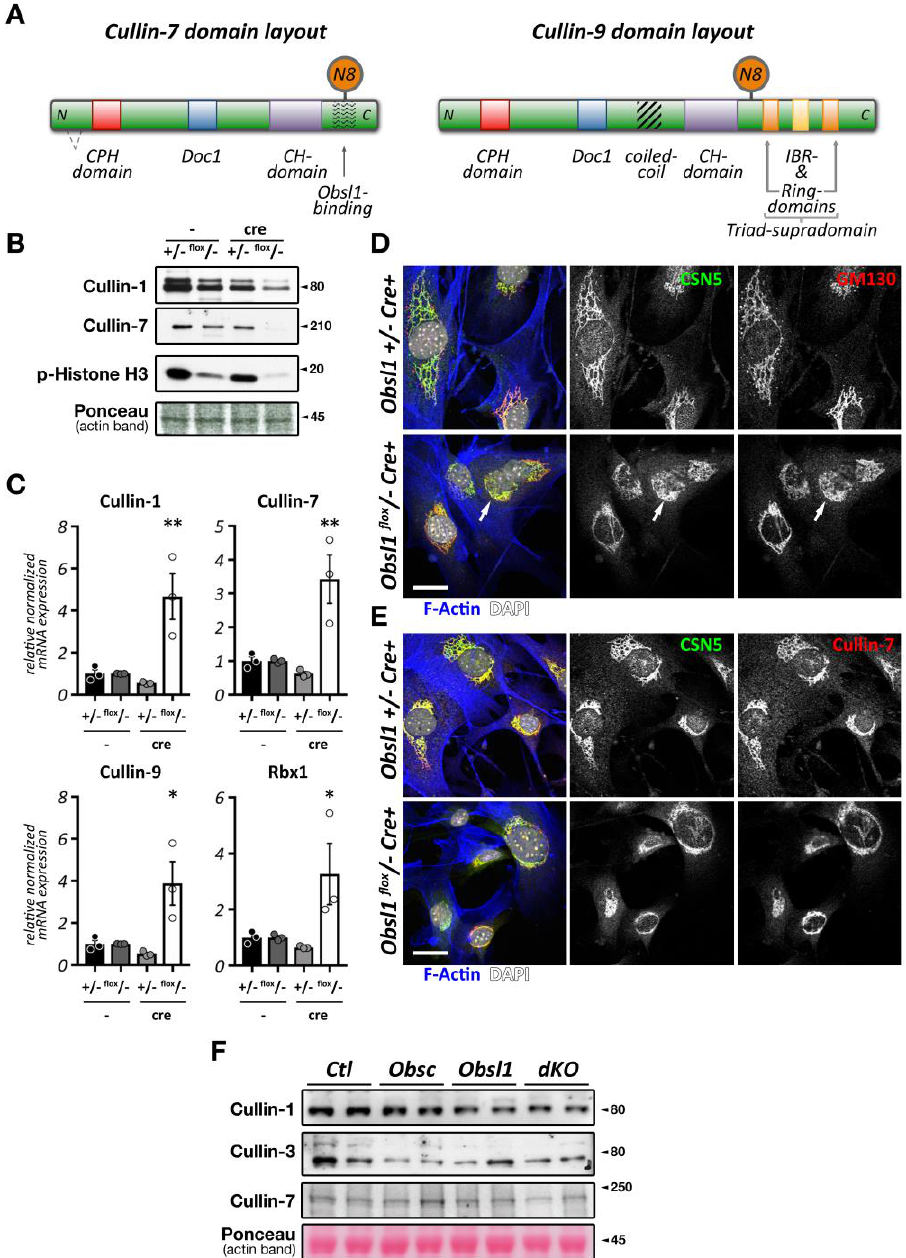
Figure 7. Cullin-7 and cullin-9 E3-ligases, and effects of Obsl1 for cullin E3-ligase expression and localization. ( A ) Cullin-7 and cullin-9 domain layout. Domain organization, mapped neddylation sites (N8), and Obsl1 interaction sites, as well as splicing in cullin-7, are shown. ( B ) Ablation of Obsl1 in mouse lung endothelial cells results in a reduction of cullin-1 and loss of cullin-7 on the protein level. Cells also show reduction in levels of phosphorylated histone H3. Ponceau stained actin bands are shown as loading controls. ( C ) Analysis of cullin-1, cullin-7, cullin-9, and Rbx1 mRNA expression levels in mouse lung endothelial cells with genetic ablation of Obsl1 . Expression was normalized to S18. * p < 0.05, ** p < 0.01 vs. +/- (cre -) controls as determined by ANOVA analysis. ( D , E ) Effect of Obsl1 deletion on the localization of Cop9 subunit Csn5 (green in D,E) and cullin-7 (red in E). Cells were counterstained with GM130 (red in D), as well as fluorescently labeled phalloidin (blue in overlay) and DAPI (white in overlay). Arrow highlights areas of disorganized Golgi structure upon loss of Obsl1. Scale bar = 10µm. ( F ) Analysis of cullin-1, cullin-3, and cullin-7 protein levels in control (Ctl), obscurin knockout (Obsc), Obsl1 knockout (Obsl1), or obscurin/Obsl1 double knockout (dKO) tibialis anterior muscles. Ponceau stained actin bands are shown as loading controls. Unmodified blot images can be found in Supplemental File 2.